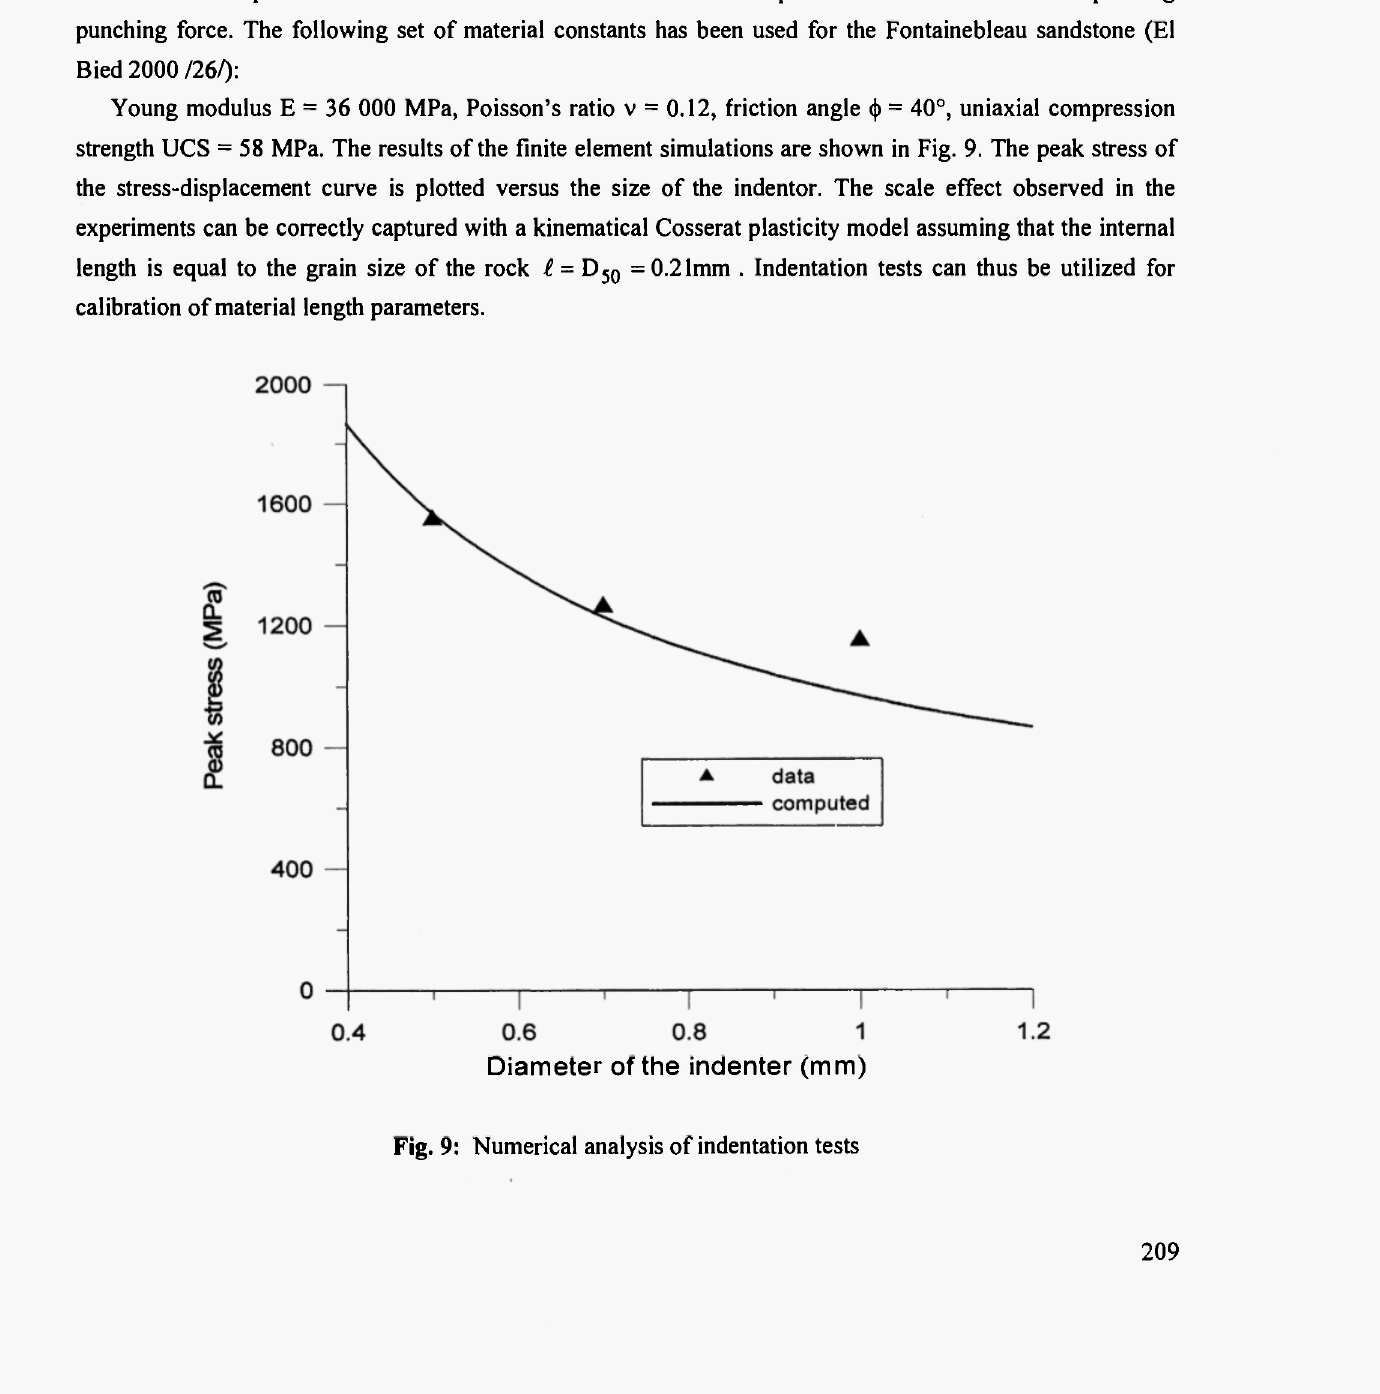
Fig. 9: Numerical analysis of indentation